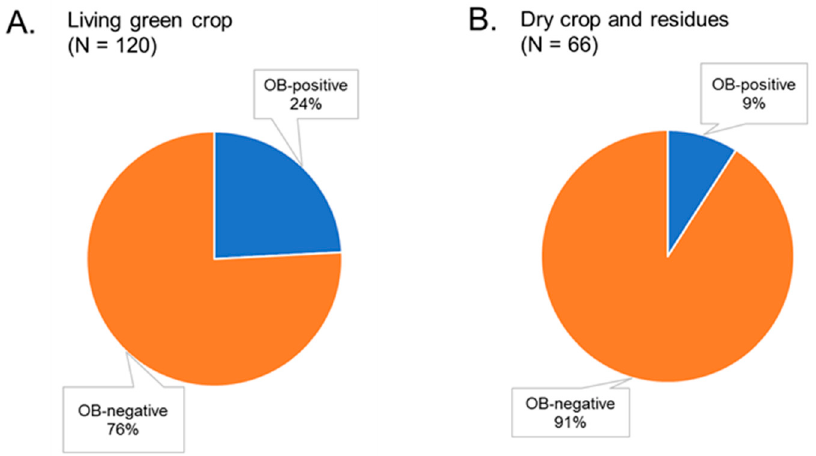
Figure 3. Prevalence of OB-positive and -negative samples taken from maize fields with ( A ) living green crops and ( B ) dry crops or post-harvest crop residues. Percentage values shown in gray rectangles are based on the indicated sample sizes (N).